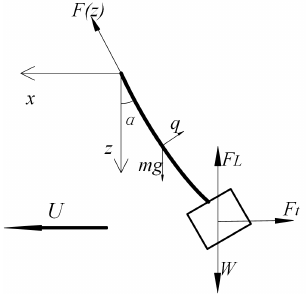
Figure 4. The force analysis of an object suspended by a wire.